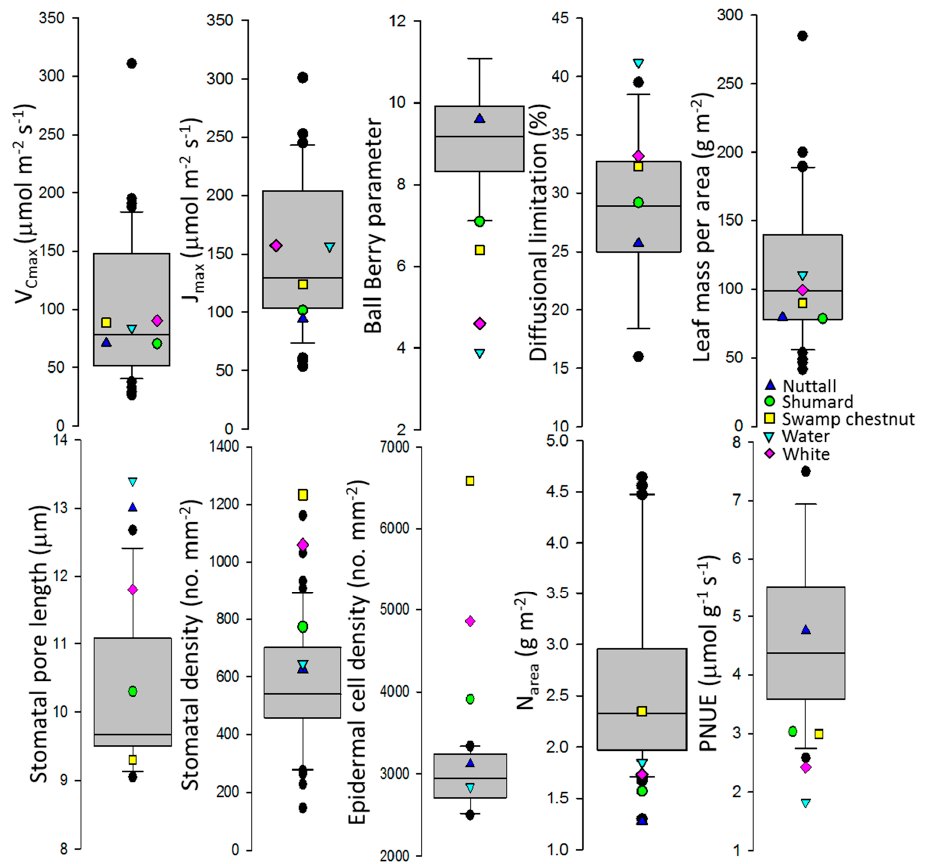
Figure 6. Boxplots of physiological and anatomical parameters for Quercus species derived from literature values (Table 1). Means for bottomland species including Nuttall (dark blue up triangle), Shumard (green circle), swamp chestnut (yellow square), water (light blue down triangle), and white oak (magenta diamond) are also presented.